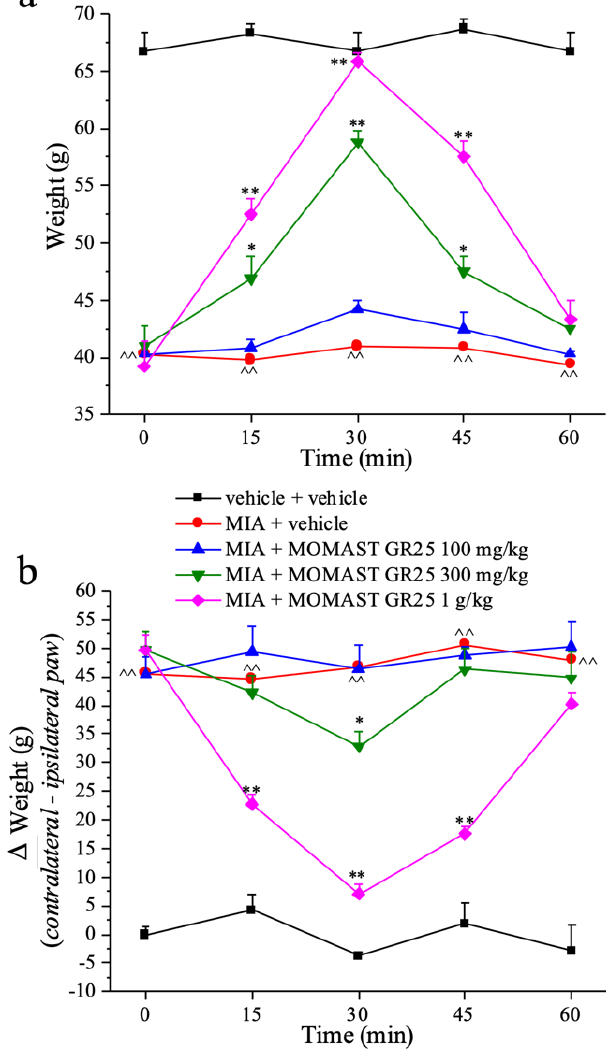
Figure 3. Effect of the acute administration of MOMAST ® GR25 on monoiodoacetate (MIA)-induced osteoarthritis in the rat, ( a ) Paw pressure test; ( b ) Incapacitance test. Osteoarthritis was induced by injection of MIA (2 mg/25 µ L) into the tibio-tarsal joint. Fourteen days after MIA injection, MOMAST ® GR25 (100 mg/kg–1 g/kg) was suspended in 1% carboxymethylcellulose sodium salt (CMC) and orally administered. Tests were performed before and after treatment. Each value represents the mean of six rats performed in two different experimental sets. One-way analysis of variance (ANOVA), p < 0.05; post-hoc test, ˆˆ p < 0.01 vs vehicle + vehicle treated animals; * p < 0.05, and ** p < 0.01 vs MIA + vehicle treated animals.